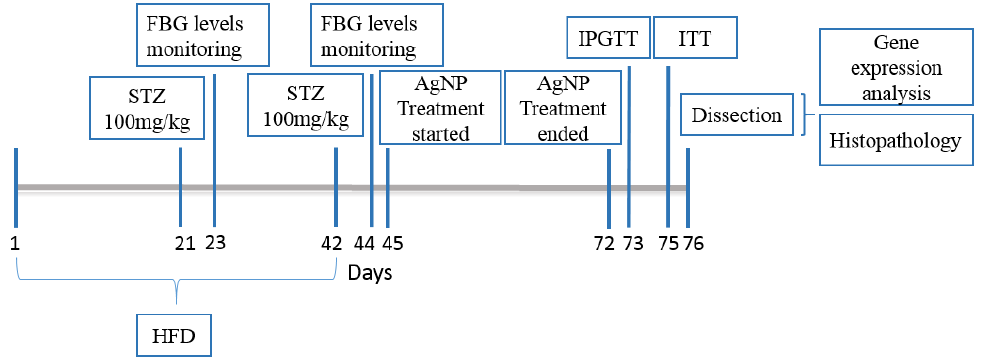
Figure 1. Timeline depicting the diabetic animal model construction and treatment